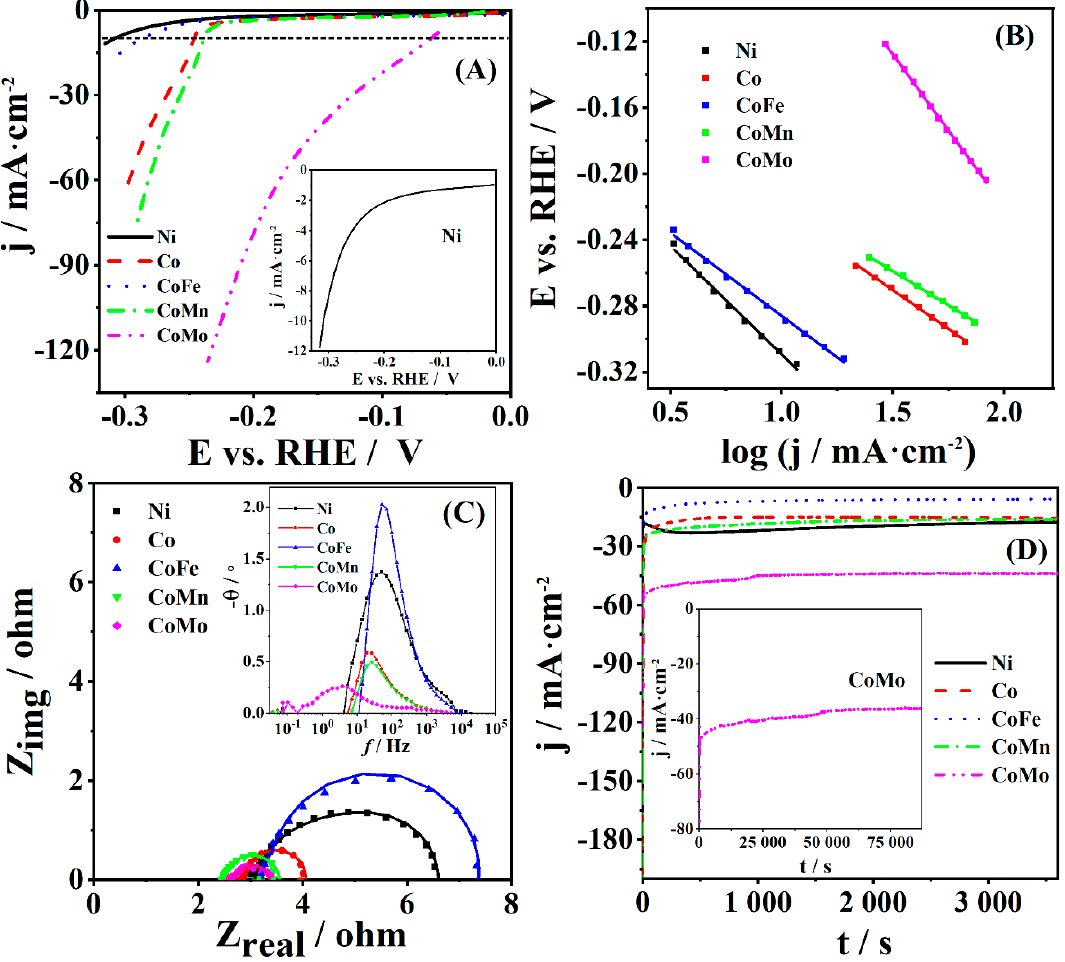
Figure 2. ( A ) Hydrogen evolution reaction (HER) polarization curves (iR-corrected) of five studied coatings at 5 mV·s − 1 with ( B ) corresponding Tafel plots, ( C ) Nyquist plots at − 0.33 V (amplitude of 5 mV in the 100 kHz–0.1 Hz range) with the corresponding Bode plots in the inset, and ( D ) chronoamperometric curves at − 0.24 V for 1 h with the chronoamperometric curve of CoMo at the same potential for 24 h (inset). All measurements were done in 1 M KOH.